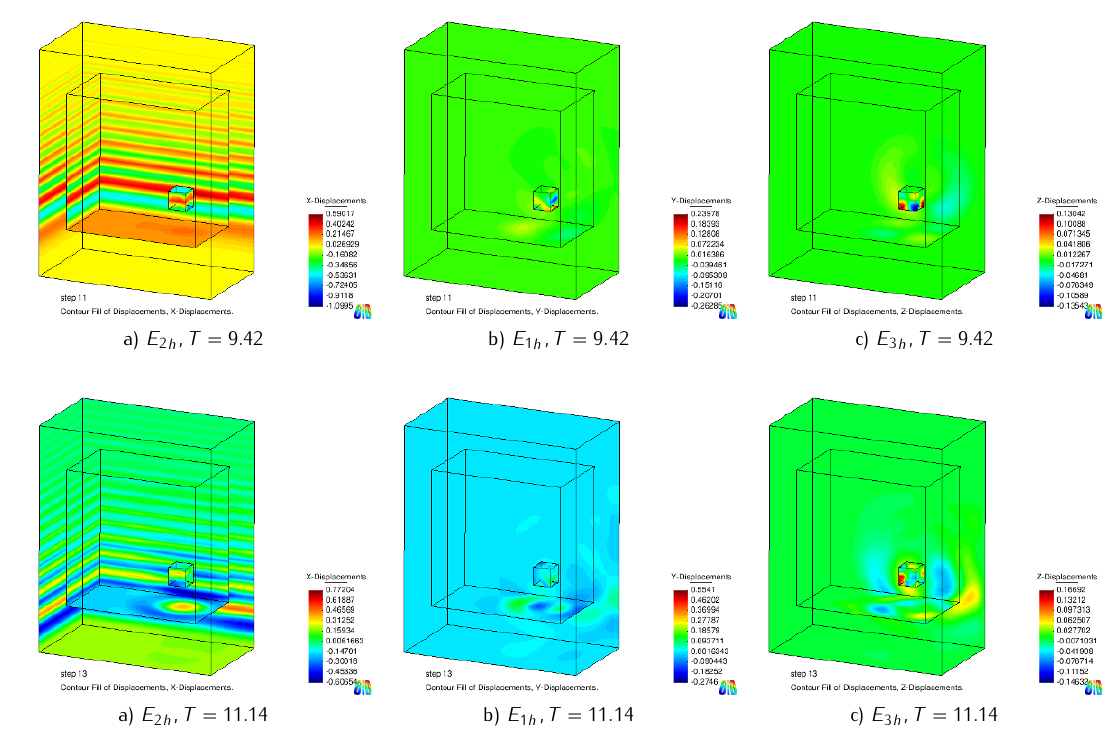
Figure 18. Test 4. Computed components of the electric field E times.